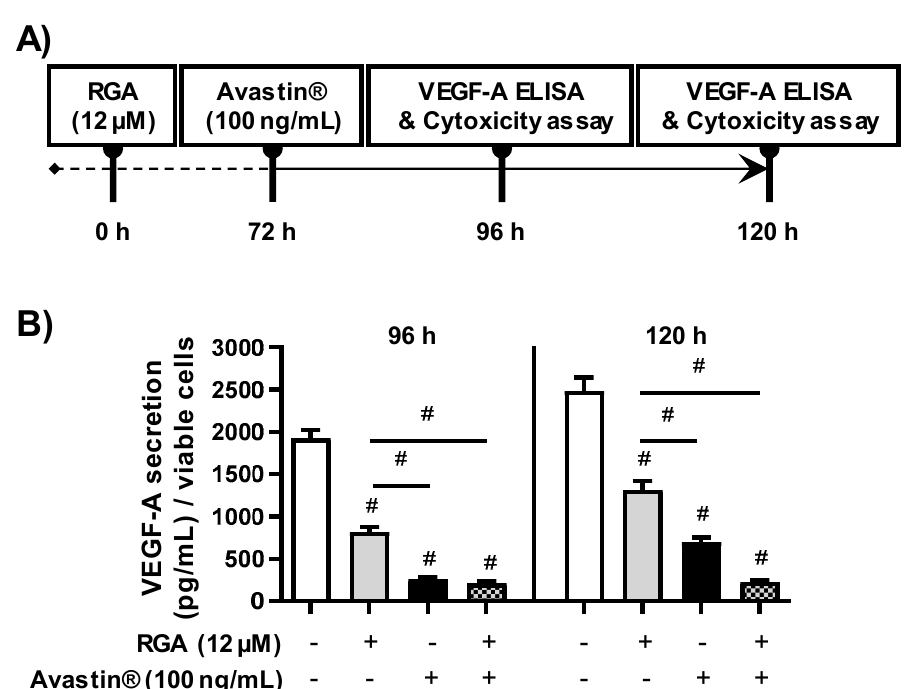
Figure 6. RSV/ ω -3 fatty acids prolong the VEGF-A inhibition induced by Avastin ® . ( A ) Experimental workflow. After 24 h of culture, ARPE-19 retina cells were treated with 12 µ M of RGA or with vehicle during 72 h, and then exposed to Avastin ® at 100 ng/mL during 24 or 48 h. At each time point, the level of VEGF-A secreted was measured by ELISA assay as well as the percentage of viable cells by crystal violet assay. ( B ) Histograms of the concentration of secreted VEGF-A (pg/mL) normalized to cell viability after 24 or 48 h or treatment with Avastin ® (100 ng/mL) in ARPE-19 retina cells, and pretreated or not with RGA (12 µ M). Data are expressed as the mean fold induction ± SEM of the three independent experiments. p values were determined by a one-way ANOVA followed by Tukey’s multiple comparison test to 2 groups (control group vs. treatment group and treatment group vs. treatment group). # p <